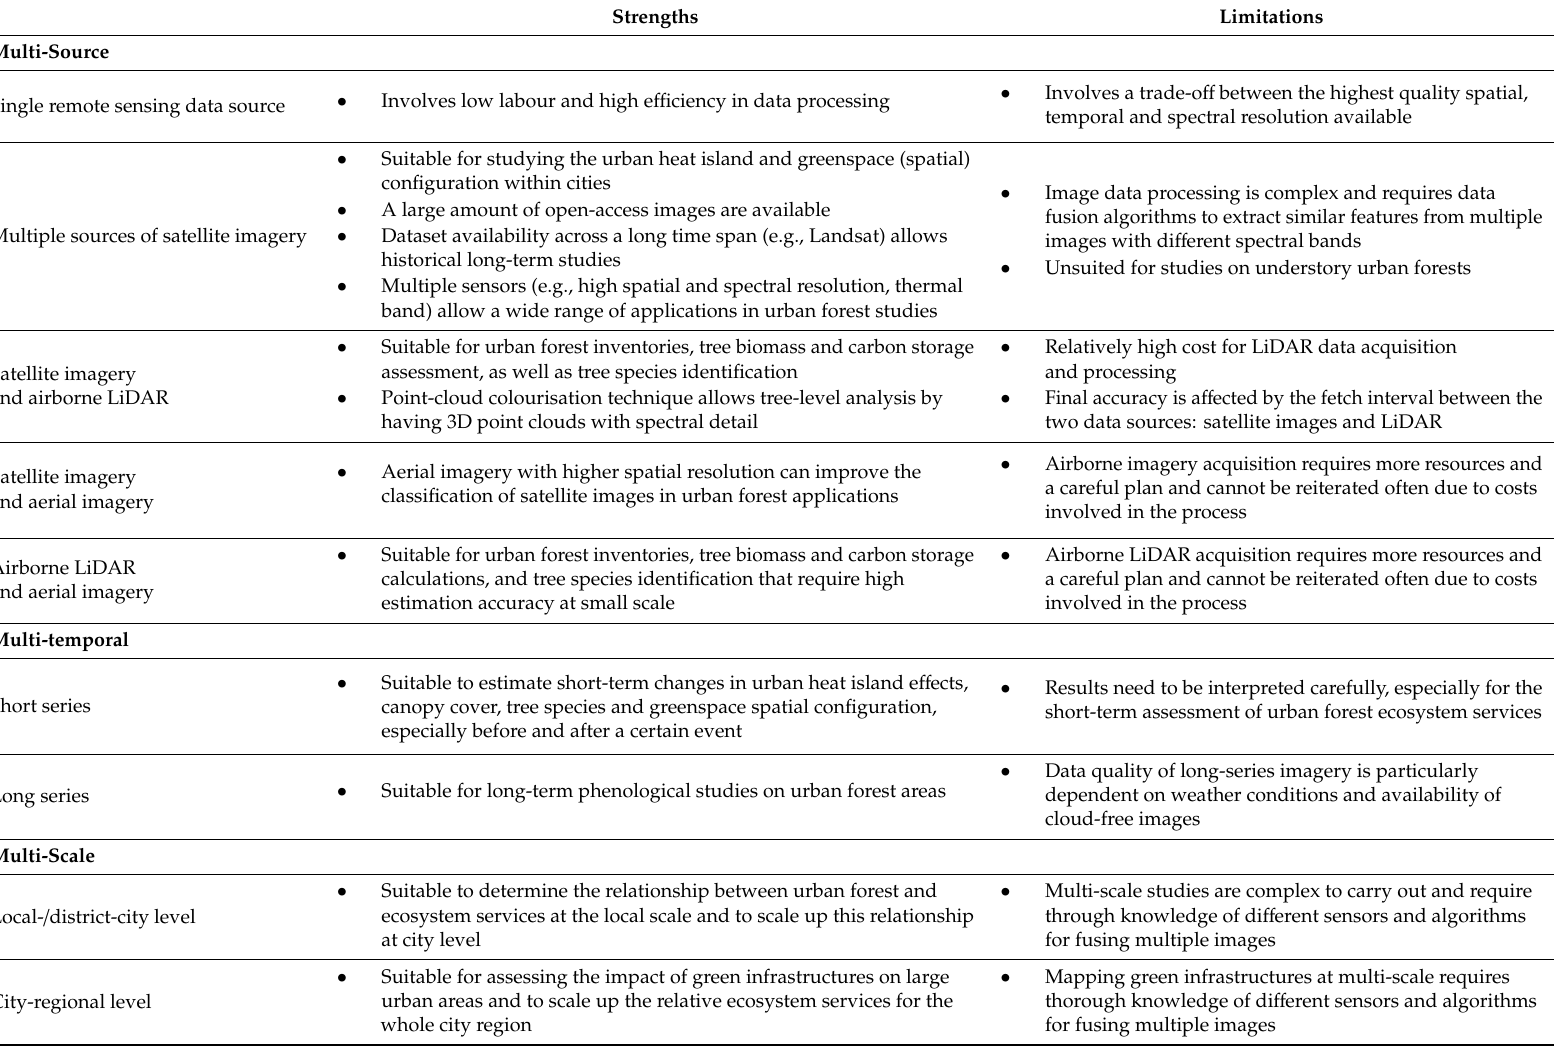
Table 2. Strengths and limitations of multi-source, multi-temporal and multi-scale